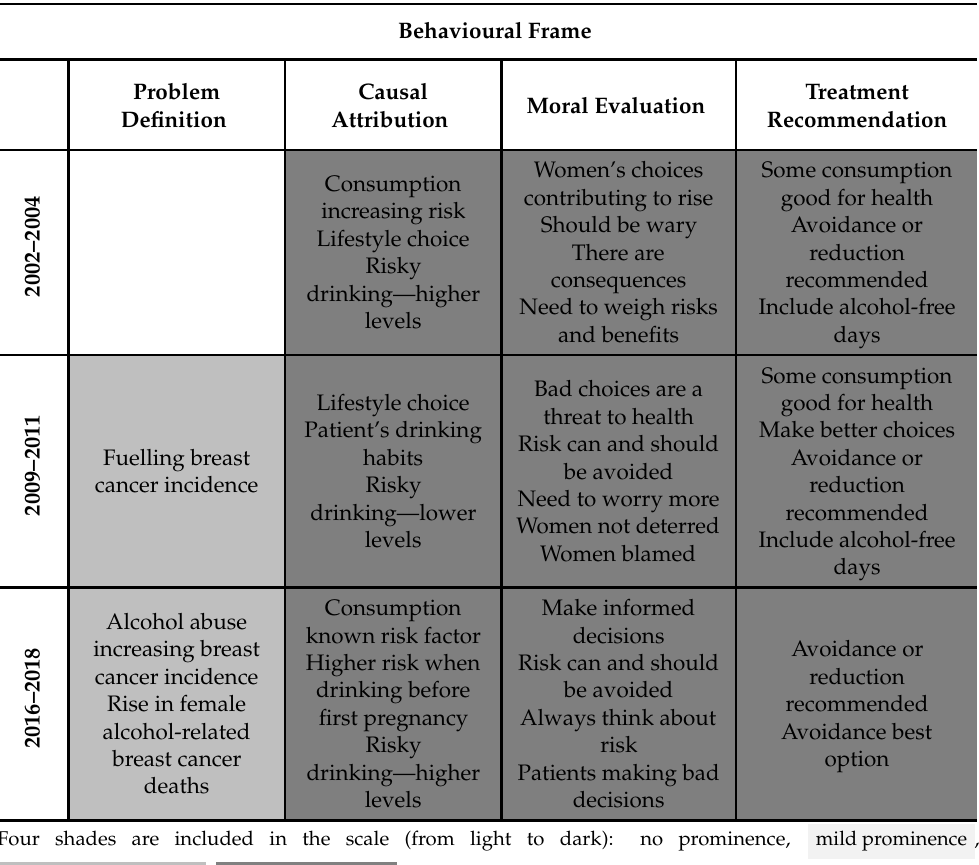
Table 2. Dominant behavioural frame